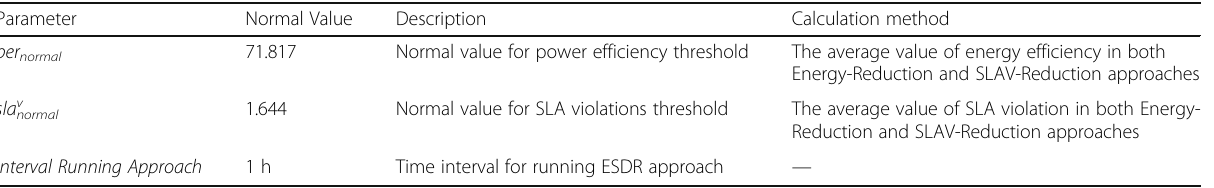
Table 2 Default values of ESDR ’ s parameters